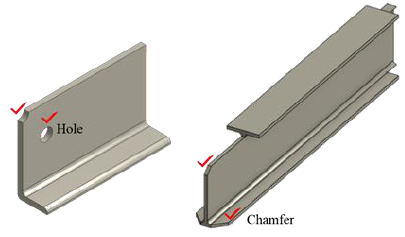
Figure 11. Beams with a hole or a chamfer.